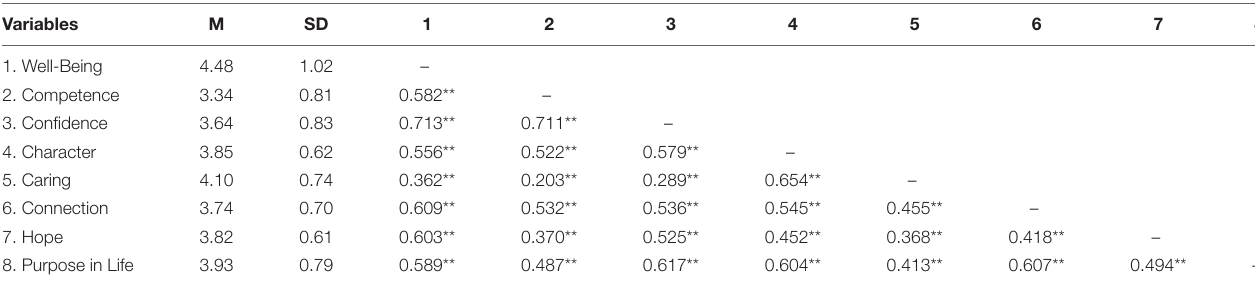
TABLE 1 | Descriptive statistics and correlations between the study constructs ( N = 393).